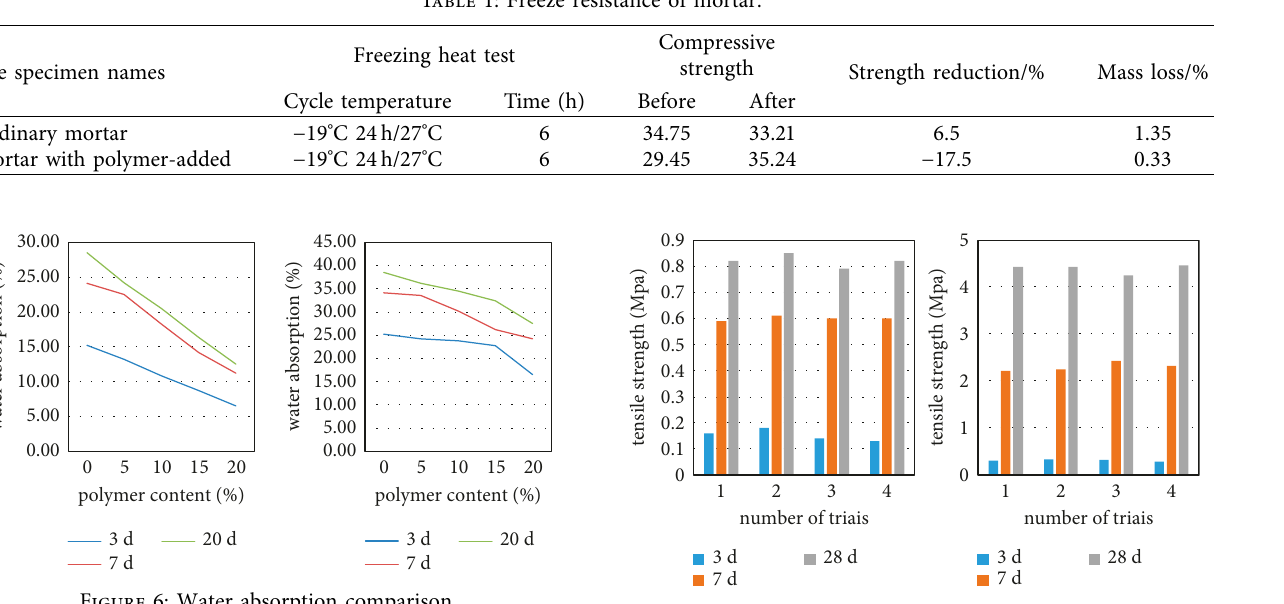
Table 1: Freeze resistance of mortar.